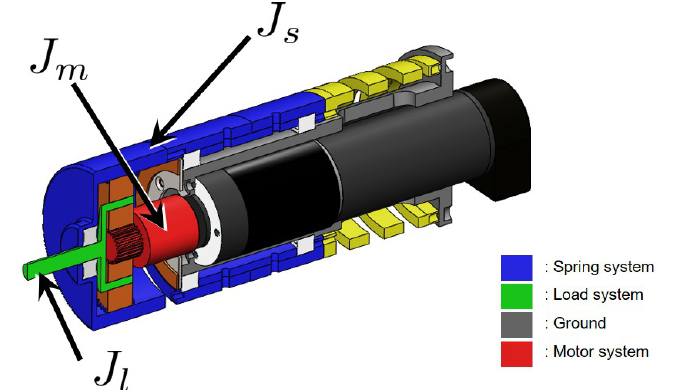
Figure 13. The inertia J m , J l and J s of cPEA